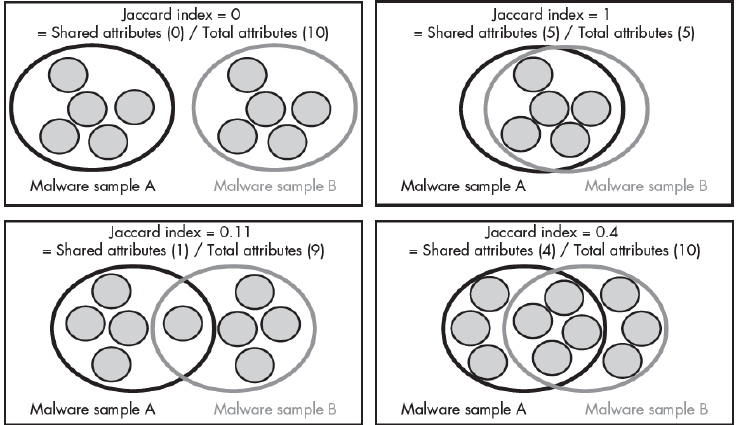
Figure 7. Jaccard Index between two malware samples. Adapted with permission from Ref. [30].